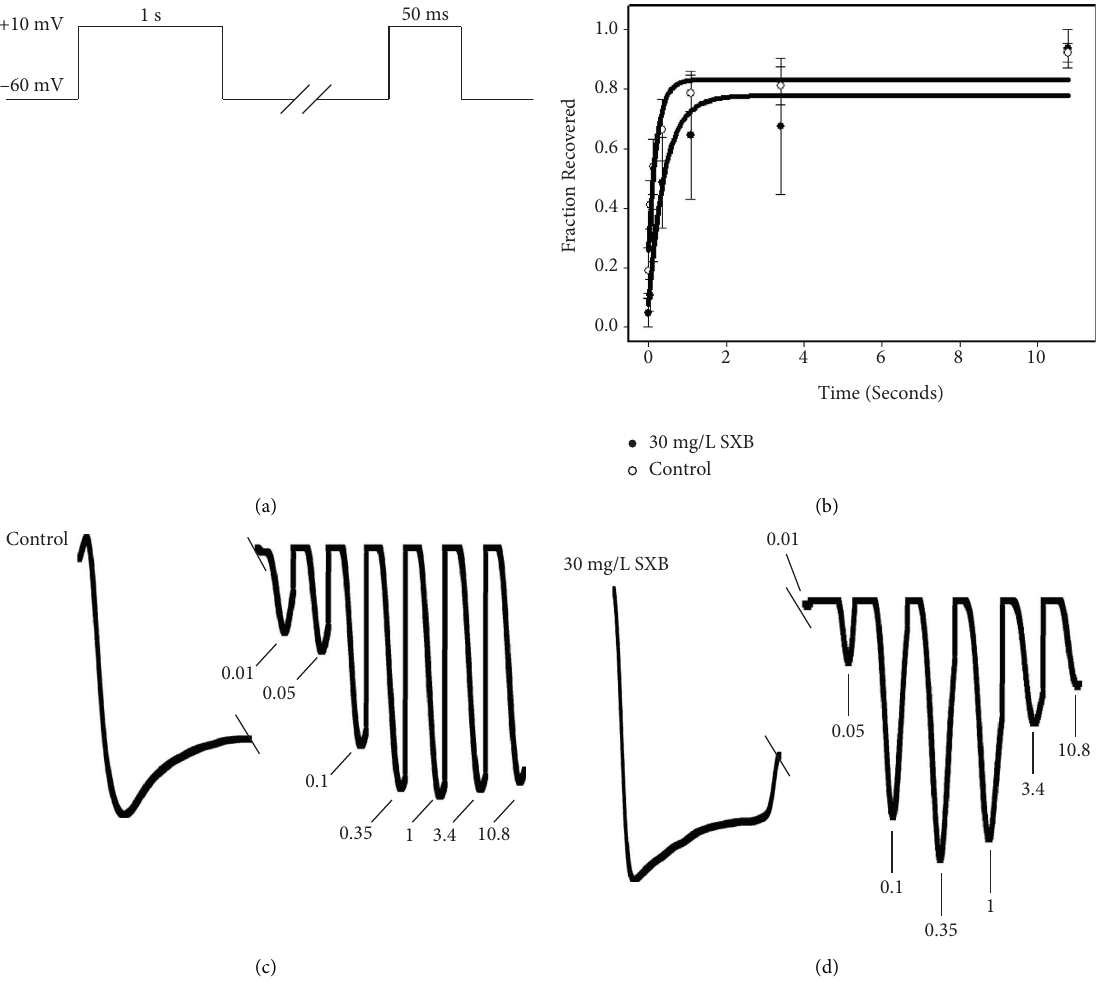
Figure 7: Te RFI changes of the hCaV1.2 channel before and after SXB perfusion. (a) A voltage protocol was detailed mentioned in the results 3.5. (b) RFI curves were plotted from the (c) control ( n � 4) and (d) 30mg/L SXB ( n �